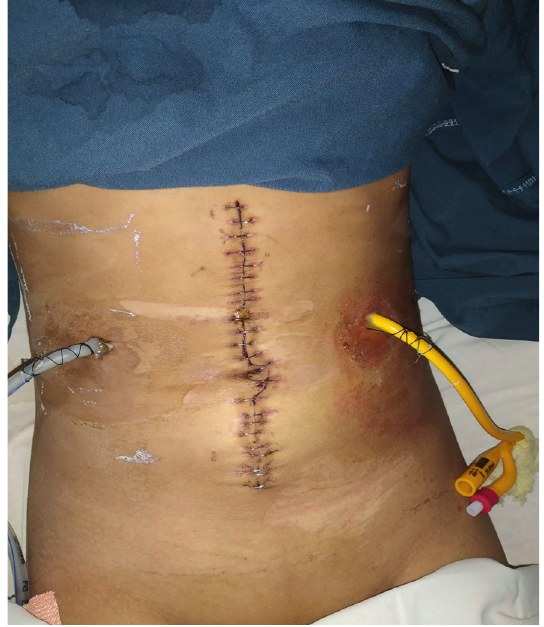
Figure 3: Subhepatic drain (right) and feeding jejunostomy tube (left) at